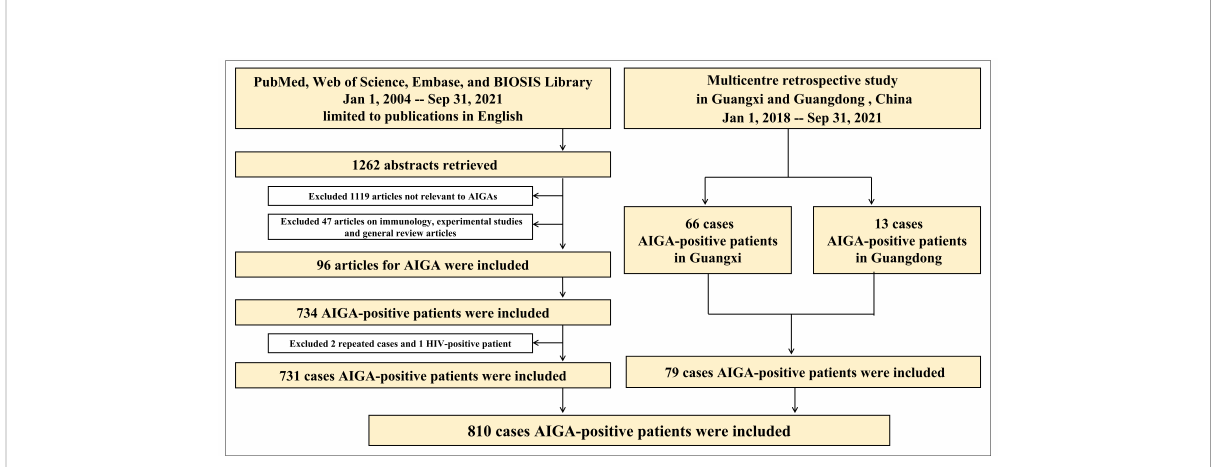
FIGURE 1 The literature search process and results of the systematic literature review and retrospective study. AIGA, anti-interferon- g